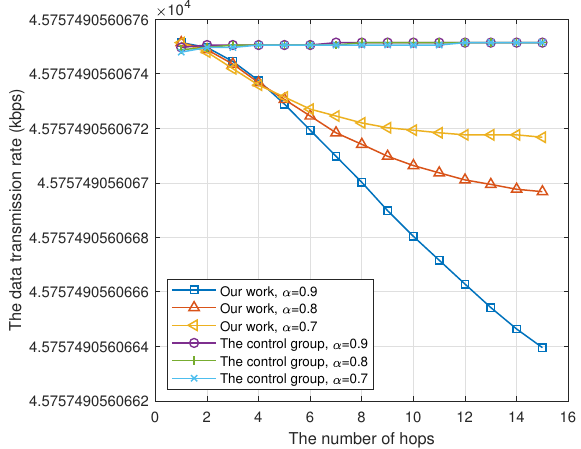
Figure 3. The data transmission rate vs. the number of hops.